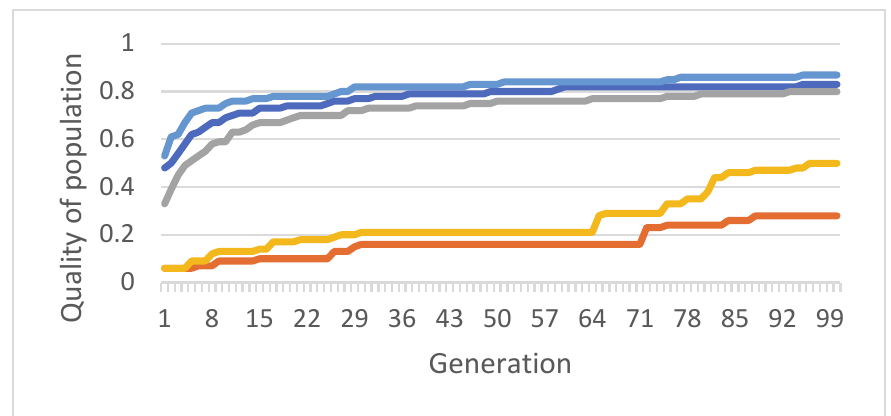
Figure 11. Convergence behavior of 5 solutions using BBA CO for WebKB dataset. Standard